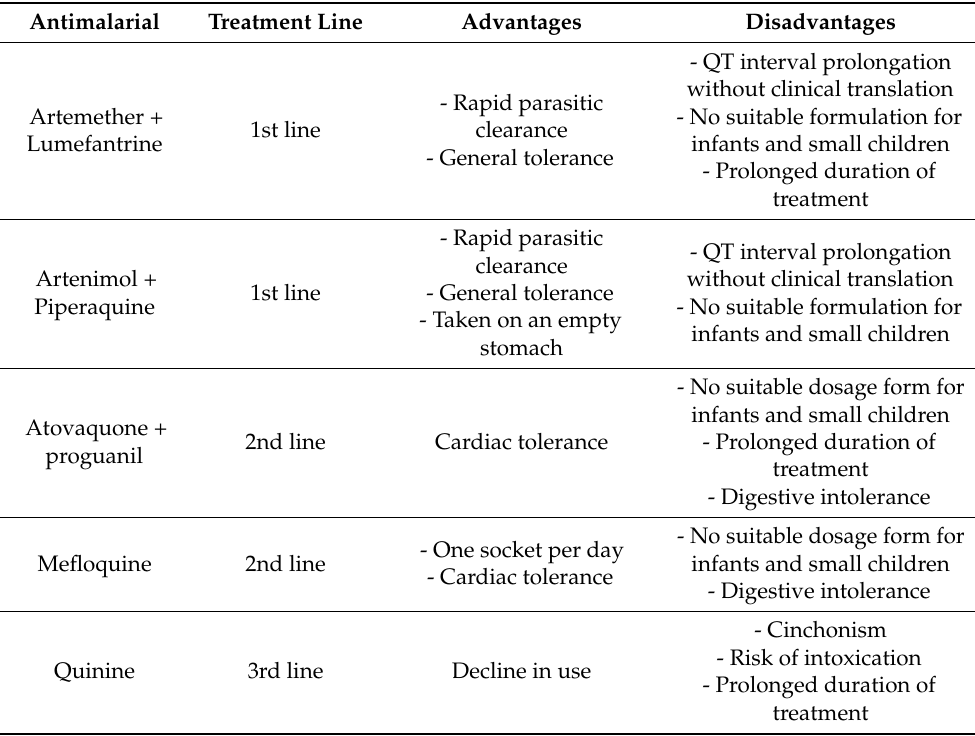
Table 3. Antimalarial drugs for the treatment of childhood malaria [35]. Antimalarial Treatment Line Advantages Disadvantages Artemether + Lumefantrine